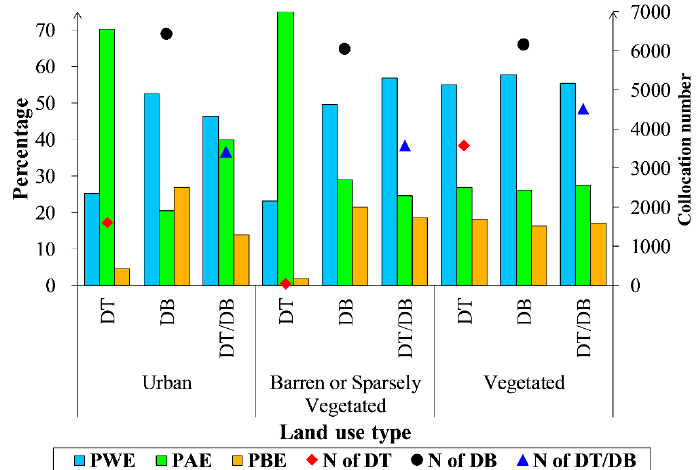
Figure 6. The percentage within in (PWE), above (PAE) and below (PBE) the expected error and the number of collocations for the DT, DB and DT/DB products over different land cover types for the years 2000–2016.